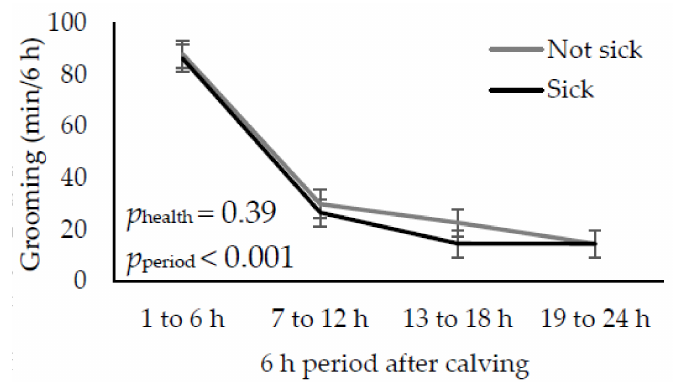
Figure 1. Least square means and standard errors for grooming behaviour directed toward the calf in the 24 h after calving for cows that were ‘sick’ (clinical sign of illness and rectal temperature ≥ 39.1 ◦ C 9 within 24 h after calving) and ‘not sick’ (no clinical sign of illness and rectal temperature ≥ 39.1 ◦ C within 3 d after calving) across 6 h periods.